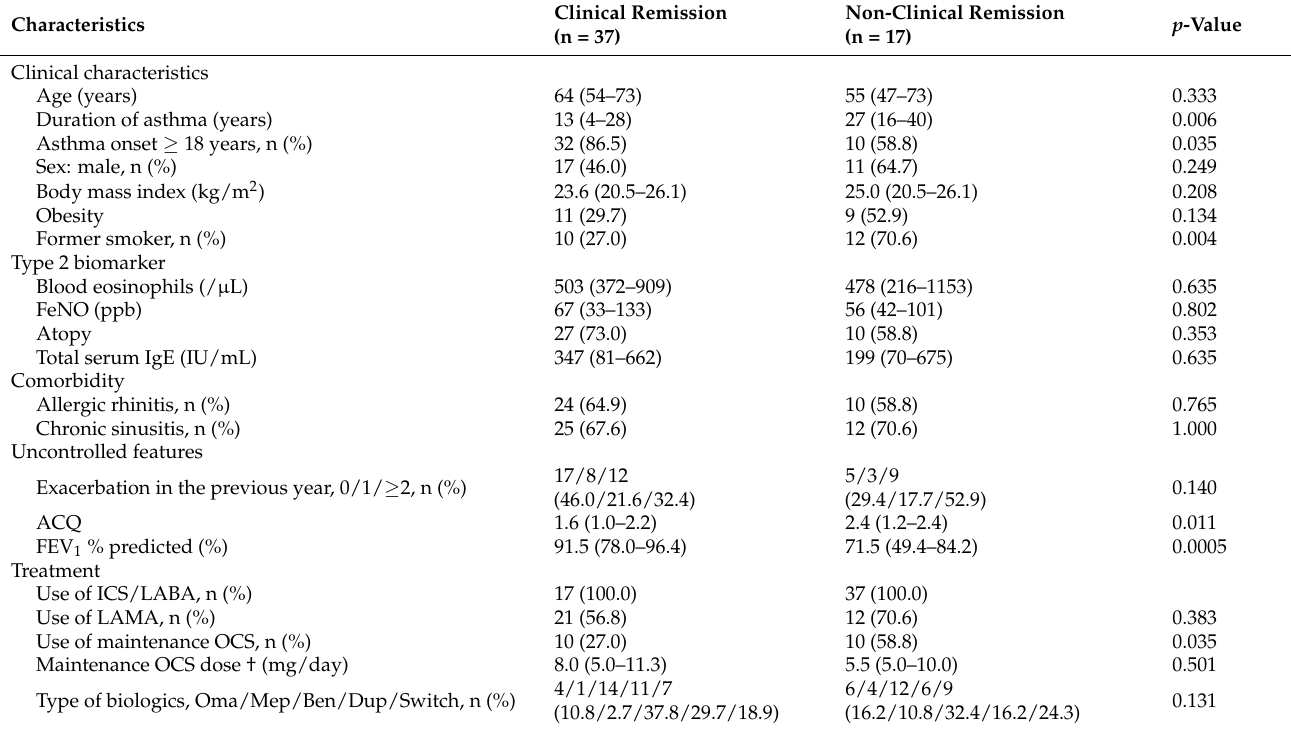
Table 2. Comparison of patient characteristics between the clinical remission and non-clinical remission